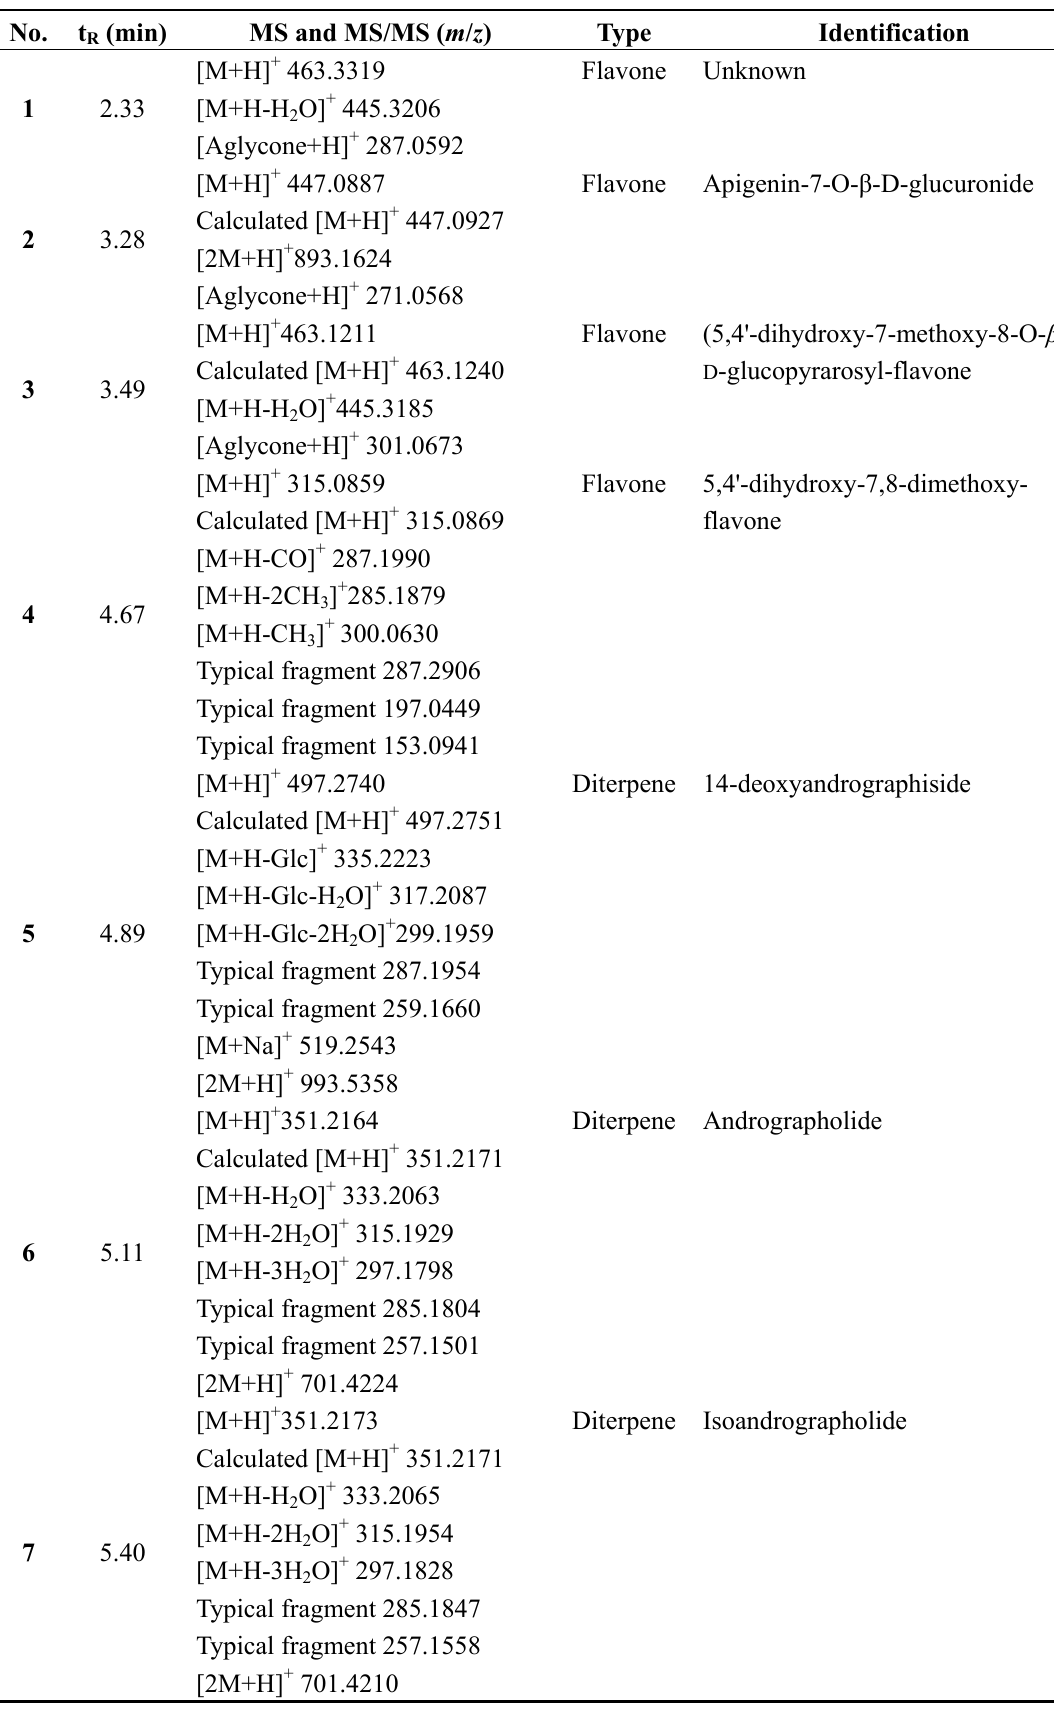
Table 1. Quasi-molecular ions of compounds in A. paniculata sample by RRLC-TOF analysis. No. t (min) MS and MS/MS ( m / z ) Type R